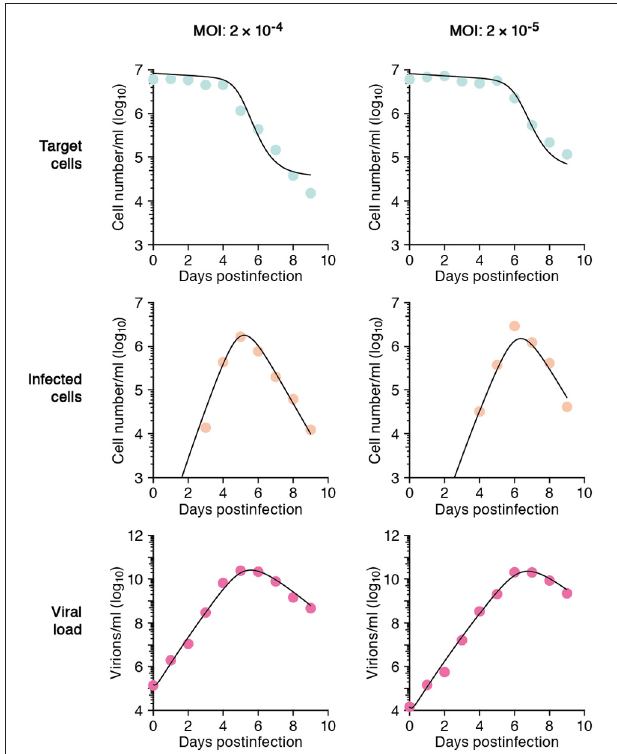
FIGURE 2 | The mathematical model describes the data well. HSC-F cells were inoculated with SHIV-KS661 24h before t = 0 and each in vitro experimental quantity was measured daily from t = 0 d to 9 d . The curves depict the best fit of the model (Equation 1), to the experimental data of SHIV-KS661 infection in vitro (symbols) for the target cells, infected cells, and the viral load for the two different experiments conducted at different MOIs. All data were fitted simultaneously as described in “Materials and Methods.”